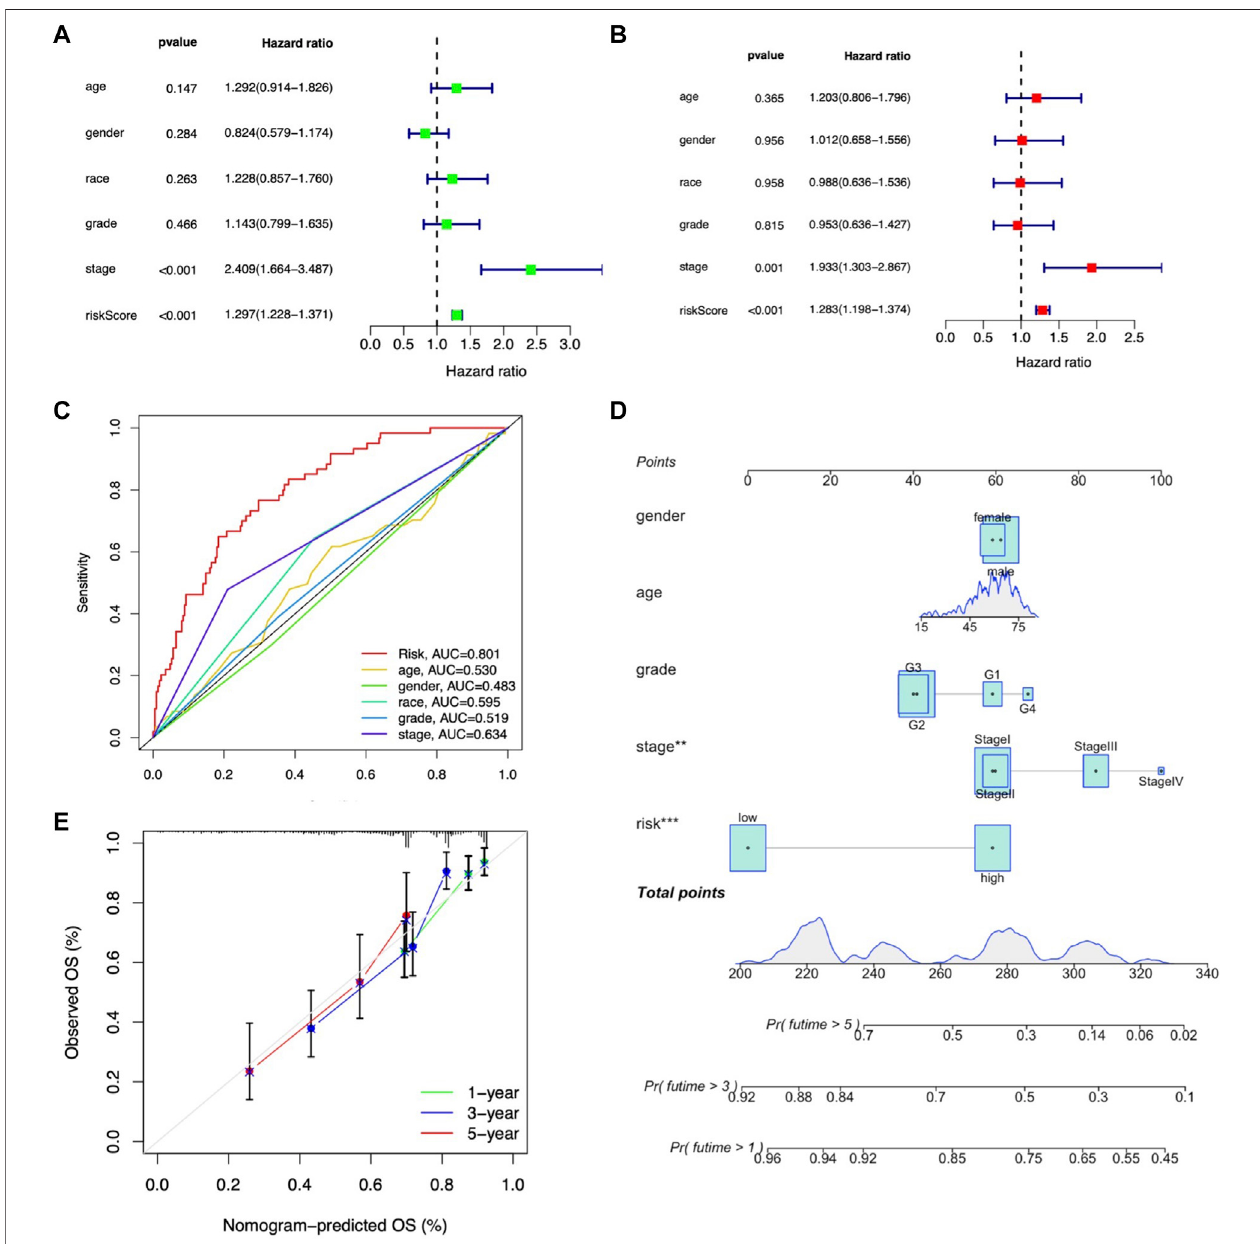
FIGURE 7 | Assessment of the independent prognostic factors and construction of a prognostic nomogram in the entire LIHC set. (A) Univariate Cox regression analysis of the clinical characteristics and risk score with the OS. (B) Multivariate Cox regression analysis of the clinical characteristics and risk score with the OS. (D) Nomogram predicting the probability of 1-, 2-, and 3-year OS. (C) ROC curves of the clinical characteristics and risk score. (E) Calibration plot of the nomogram predicting the probability of the 1-, 2-, and 3-year OS.